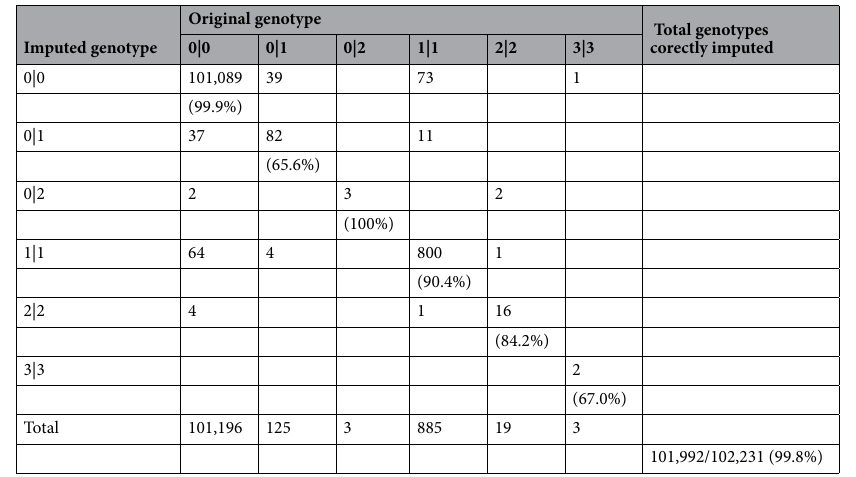
Table 8. Empirical accuracy of imputing sporadic missing genotypes in mitogenomes. Number of correctly imputed genotypes (percentage correct in brackets) on the diagonals and number of genotypes wrongly imputed shown on the off-diagonals. Assessment was based on randomly masking of 10% of positions (307) per animal in 20% of animals